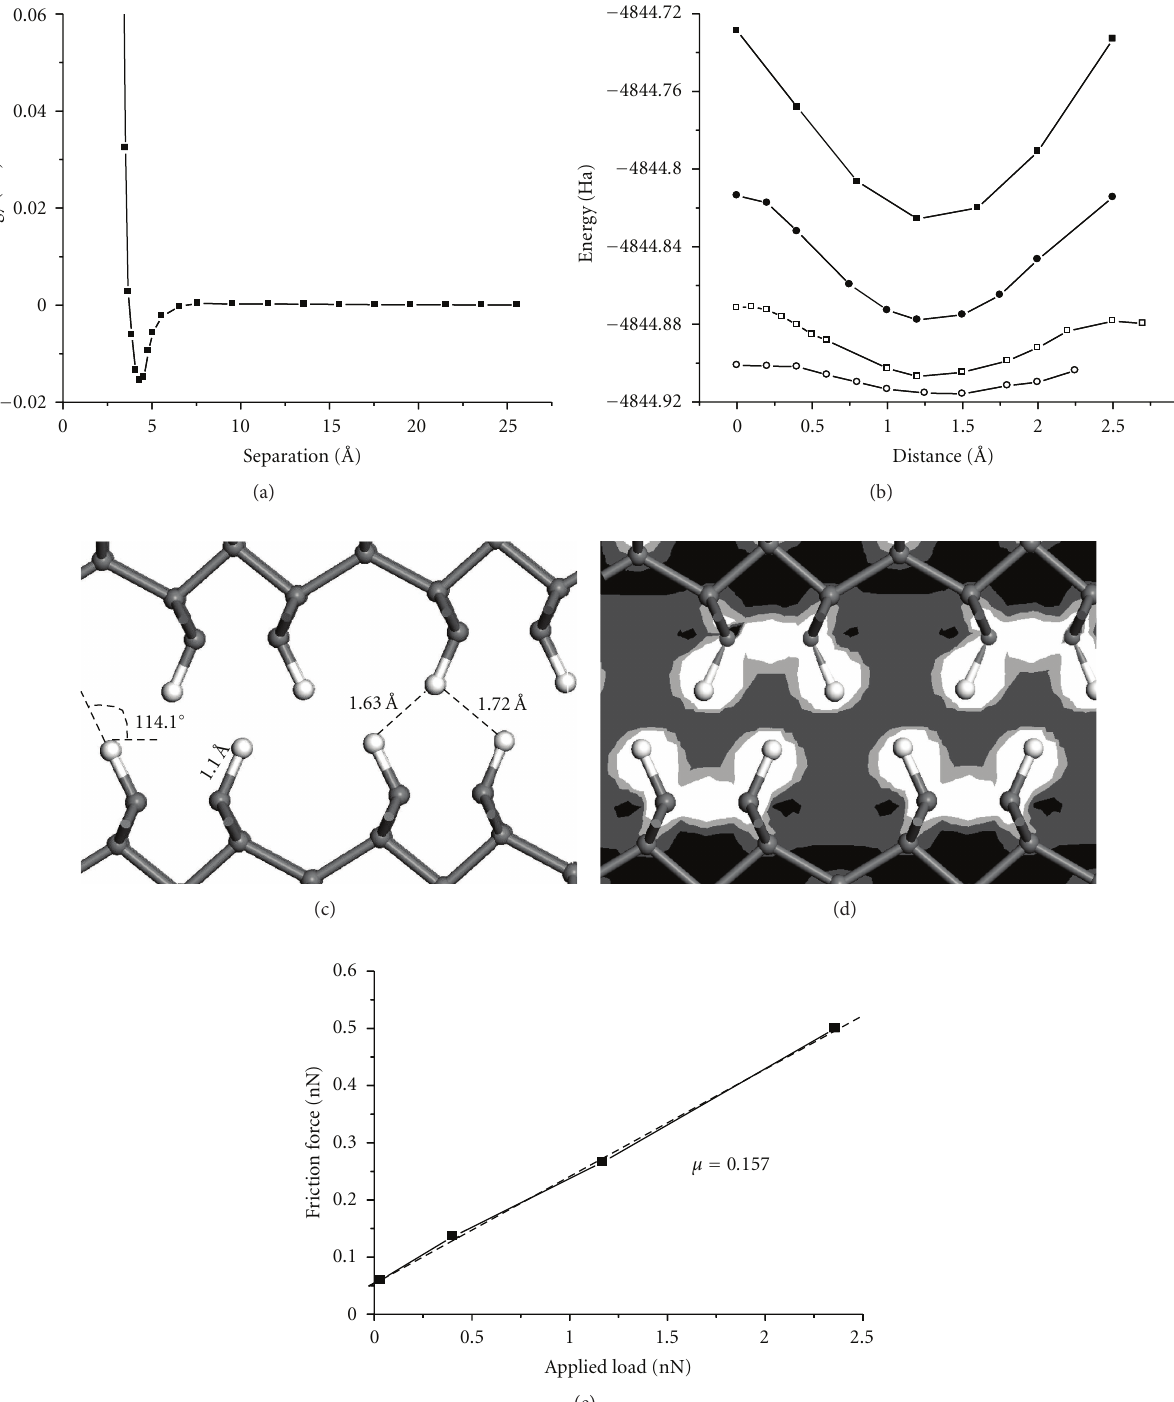
Figure 3: (a) The total energy difference (with separated configuration at 25 ˚A) of two C(100)2x1-H surfaces with incrementally decreasing separation, a cohesive interaction at approximately 4.5 ˚A separation is observed with increasingly repulsive interactions at smaller spacing (distance as measured between the carbon atoms of the dimer between upper and lower surfaces). (b) Total energy of interaction of C(100)2x1- H surfaces at fixed distance and load while surfaces are slid in the (100) plane: open circle load is 0.0326 nN, open square load is 0.4034 nN, solid circle load is 1.1694 nN, and solid square load is 2.3590 nN. (c) Geometry of interacting surfaces at 3.24 ˚A (Figure 1(c)) spacing when translated ∼ 1.2nm into relative minima, showing relative positions of opposing hydrogen atoms. (d) Electron density difference map of part (c) coloration as described in Figure 2(c). (e) Friction force derived from part (b) as a function of applied load, coefficient of friction is 𝜇 =